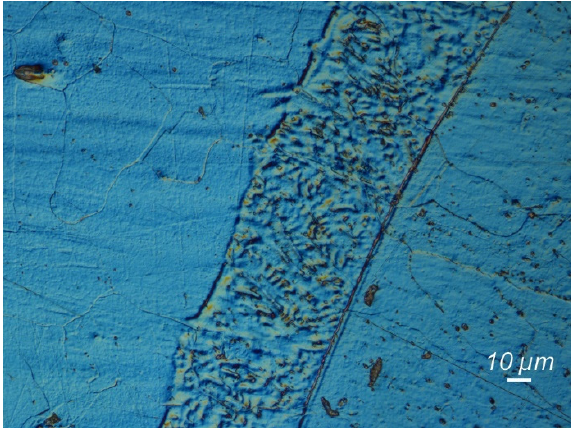
Figure 11. Micrograph showing interface between weld–fusion line and 304L austenitic stainless steel (Nomarski contrast).